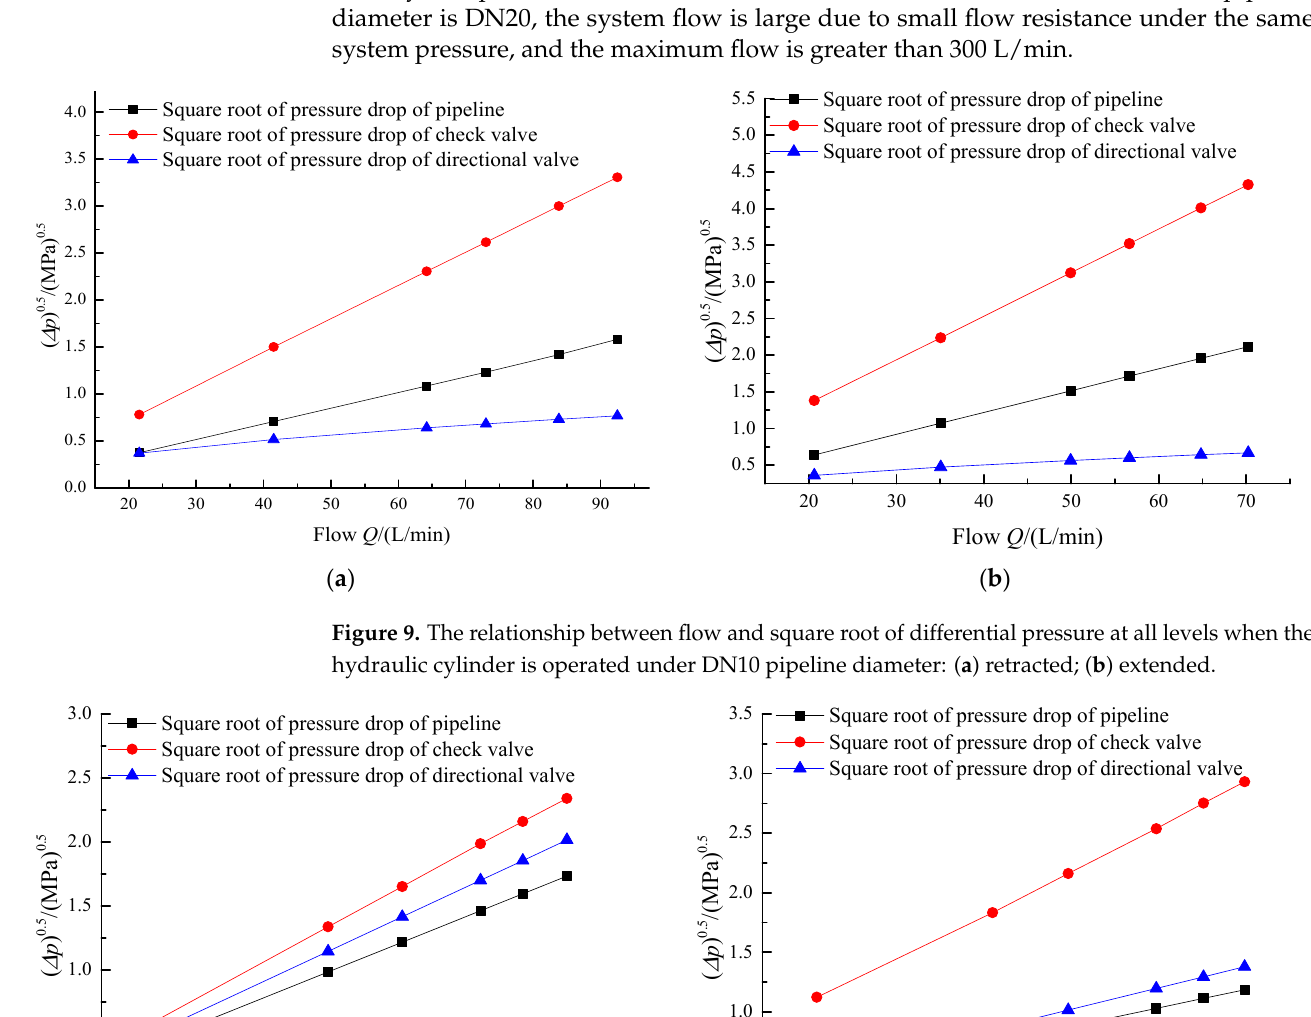
Table 7. System parameters table under different liquid supply conditions.